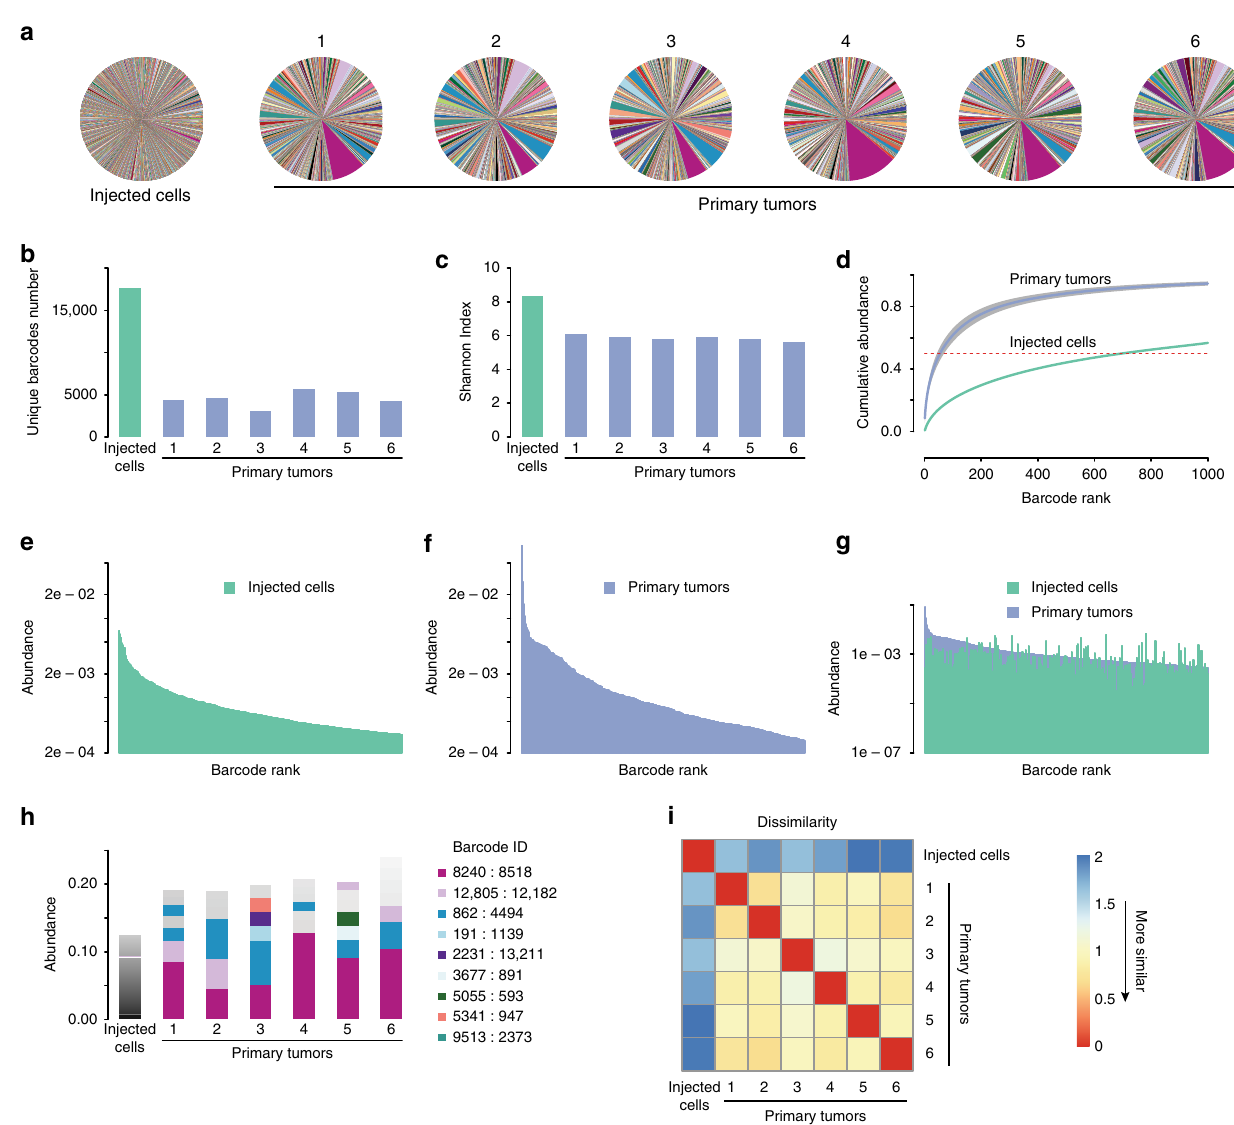
Fig. 2 Independent primary tumors have similar clonal composition. a Pie charts showing the relative frequency of barcodes in the starting cell population and six independent primary tumors. Note that individual barcodes are represented by the same color in each pie chart. b Number of unique barcodes detected in the starting cell population and six independent primary tumors. n = 1 for the injected cell population and n = 6 biologically independent primary tumors. c Shannon diversity index showing barcode complexity of the starting cell population and six independent primary tumors. n = 1 for the injected cell population and n = 6 biologically independent primary tumors. d Cumulative abundance plots for the starting cell population and the average of six primary tumors, demonstrating that barcode complexity decreases during primary tumor growth. e Barcode abundance in the starting cell population. Barcodes are ranked on the x -axis from most to least abundant. f Barcode abundance in a representative primary tumor. Barcodes are ranked on the x -axis from most to least abundant. g Comparison of barcode distribution in the starting cell population and a representative tumor, showing that the most abundant barcodes in tumors were not abundant in the starting population. Barcodes are ranked on the x -axis based on their abundance in the primary tumor. h A subset of barcodes is reproducibly enriched in independent primary tumors. The most abundant barcodes in each sample are shown, with each color denoting a unique barcode. Note that barcode colors match pie charts in a . n = 1 for the injected cell population and n = 6 biologically independent primary tumors. i Correlation matrix showing the similarity in barcode abundance between samples. Primary tumors had similar barcode distributions to one another, but were distinct from the starting population. The Jensen – Shannon divergence was used to measure dissimilarity among